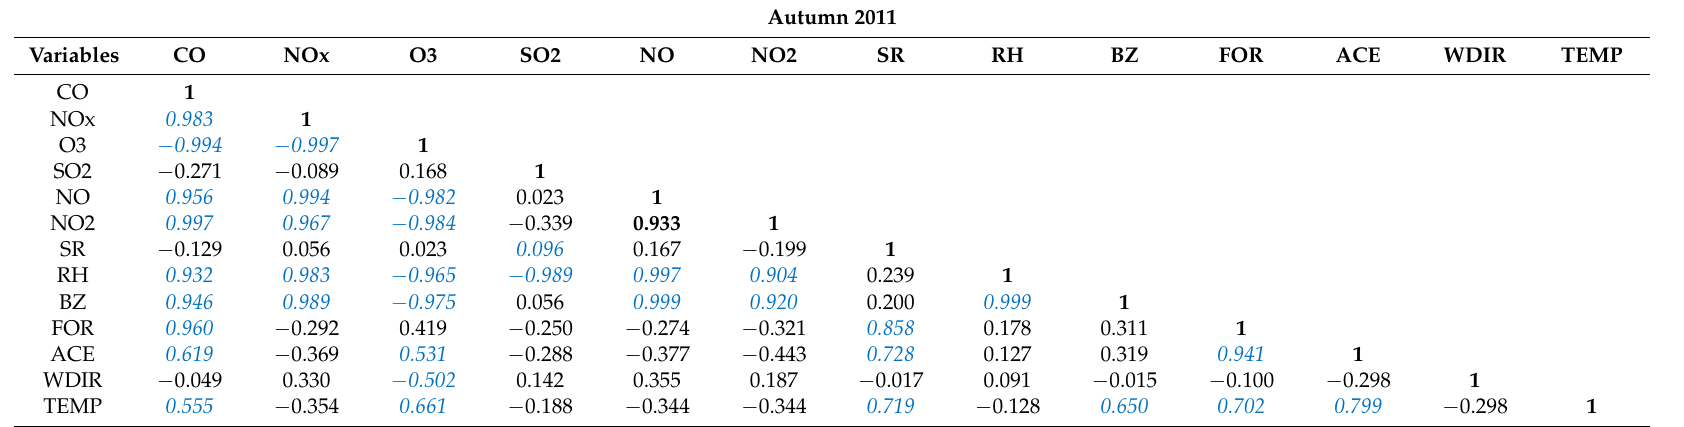
Table 6. Pearson correlation coefficients for benzene, formaldehyde, acetaldehyde, meteorological parameters, and criteria air pollutants during